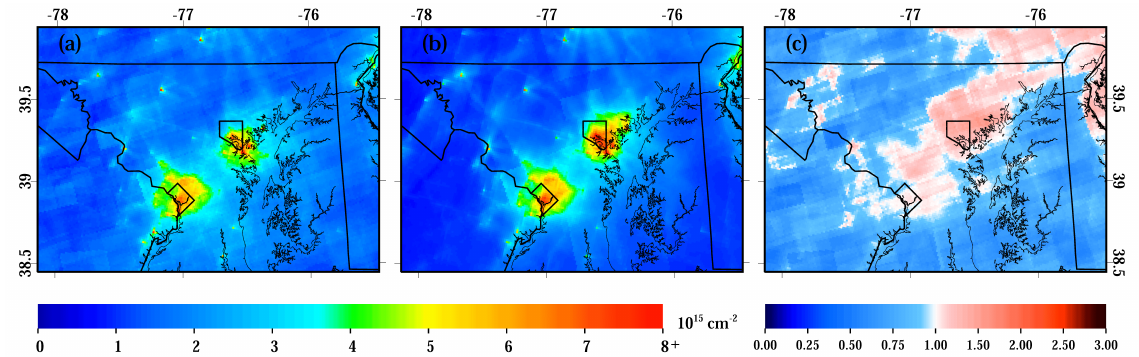
Figure 10. Oversampled tropospheric column NO 2 at 1.33km in the Baltimore–Washington metropolitan area for June and July 2011 only. (a) OMI_CMAQ_OD. (b) CMAQ NO 2 corresponding to valid overpass times. (c) Ratio between the two plots